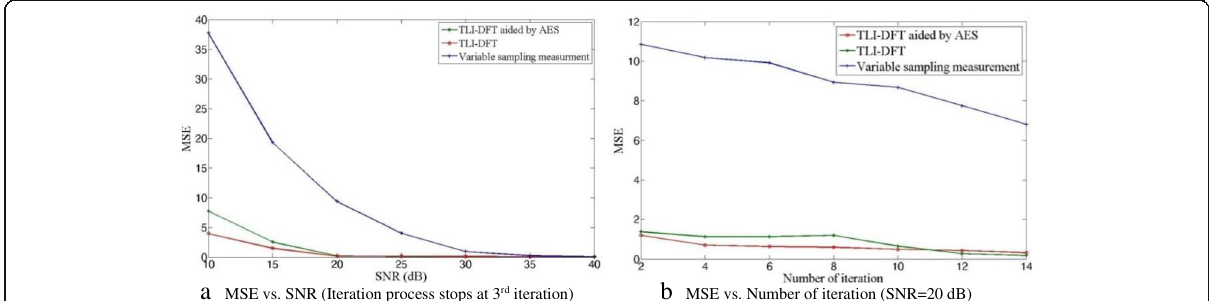
Fig. 10 Performance comparison of three algorithms in scenario 2 ( a = 0.04, f m = 2